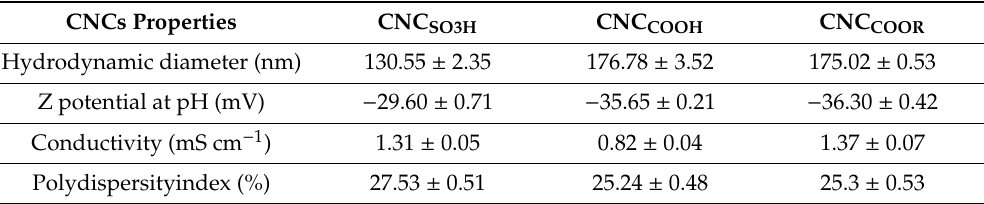
Table 1. Properties of dispersed cellulose